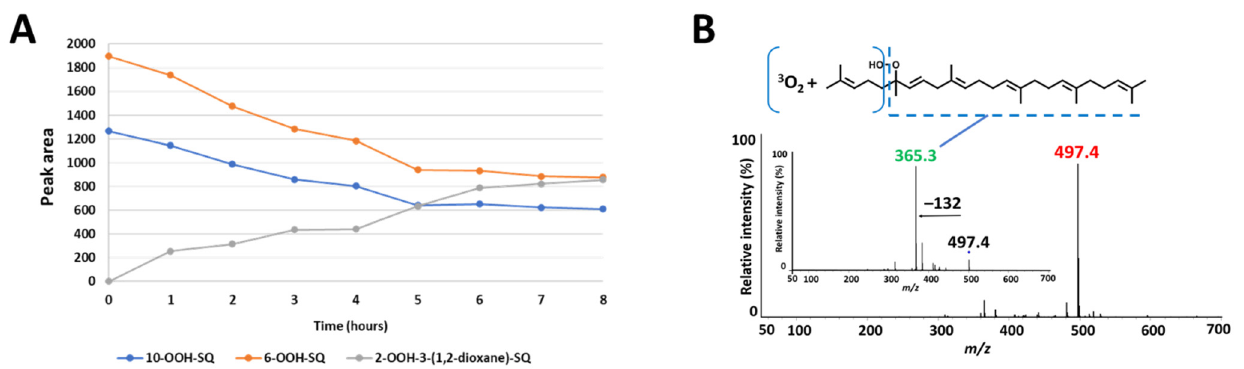
Figure 3. ( A ) correlation between the decrease in 10-OOH-SQ, 6-OOH-SQ and the increase in 2-OOH-3-(1,2-dioxane)-SQ. The peak area of 6-OOH-SQ decreased by a value of 1019 while 2-OOH-3-(1,2-dioxane)-SQ’s peak area reached 856 after 8 h, equal to 84% of the decreased 6-OOH-SQ. ( B ) Q1 and product ion scan (PIS) spectra of the newly observed SQ secondary oxidation product.